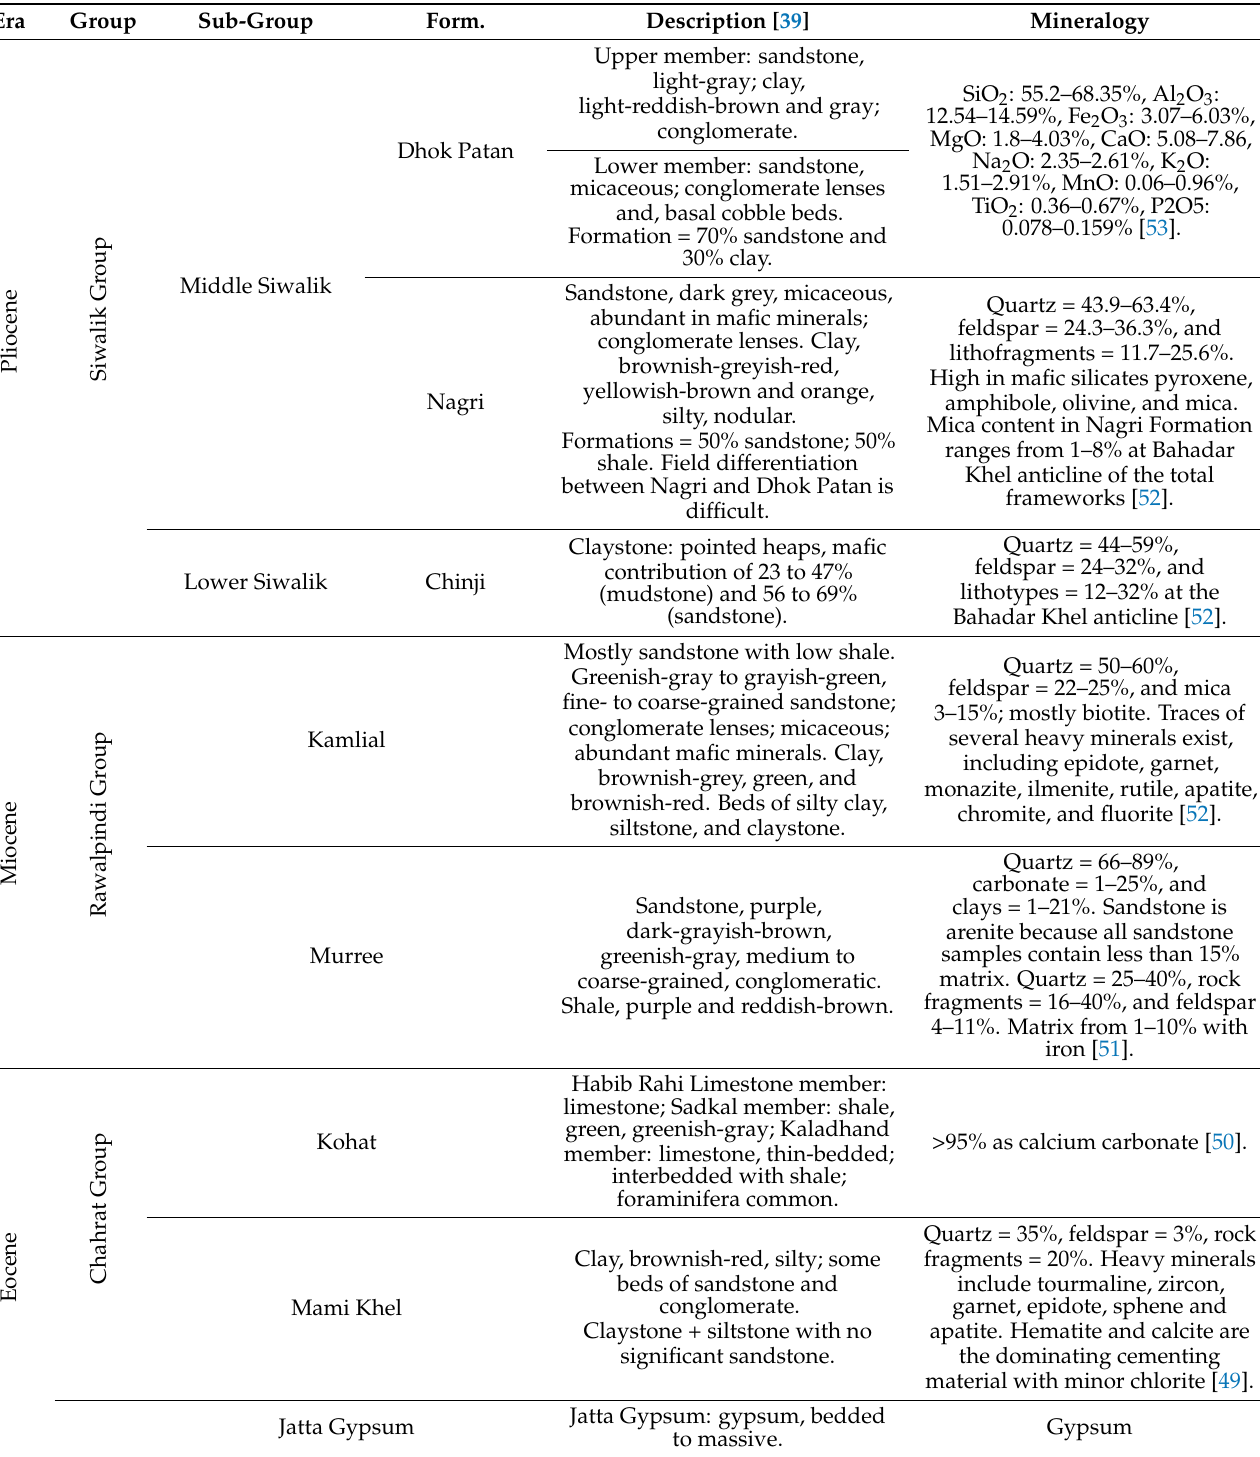
Table A1. Stratigraphic sequencing and mineralogy of various formations in the region of